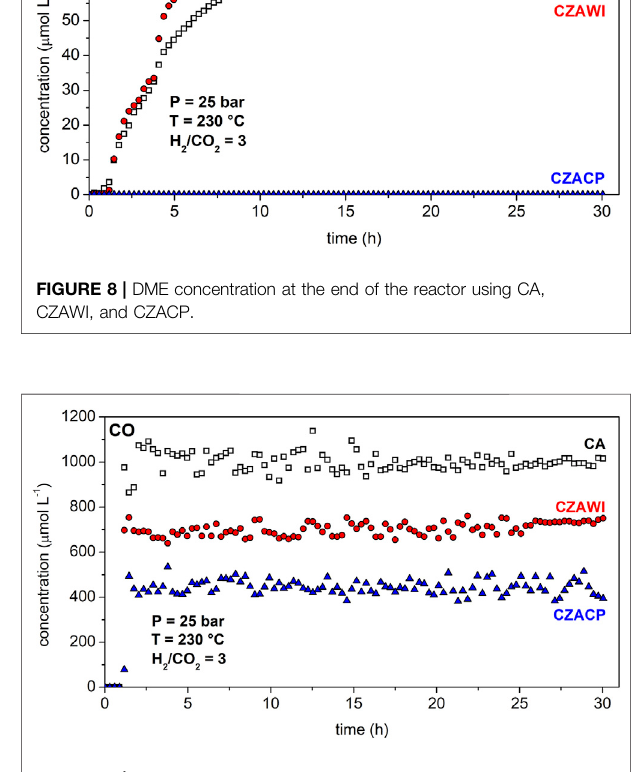
FIGURE 9 | CO concentration at the end of the reactor using CA, CZAWI, and CZACP.